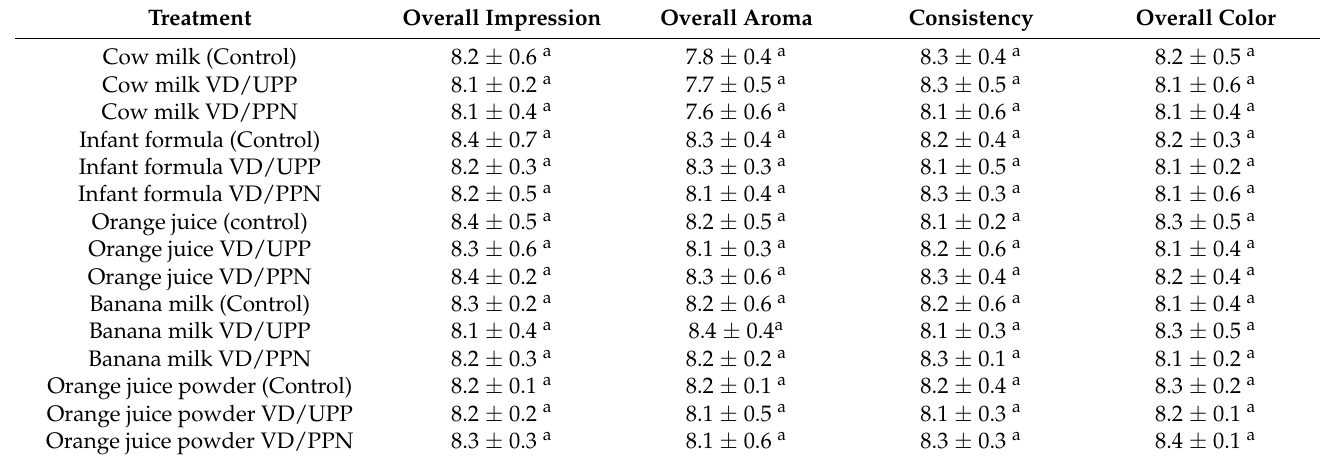
Table 8. Consumer testing of various food products after Vitamin D fortification using UPP and PPN. Treatment Overall Impression Overall Aroma Consistency Overall Color Cow milk